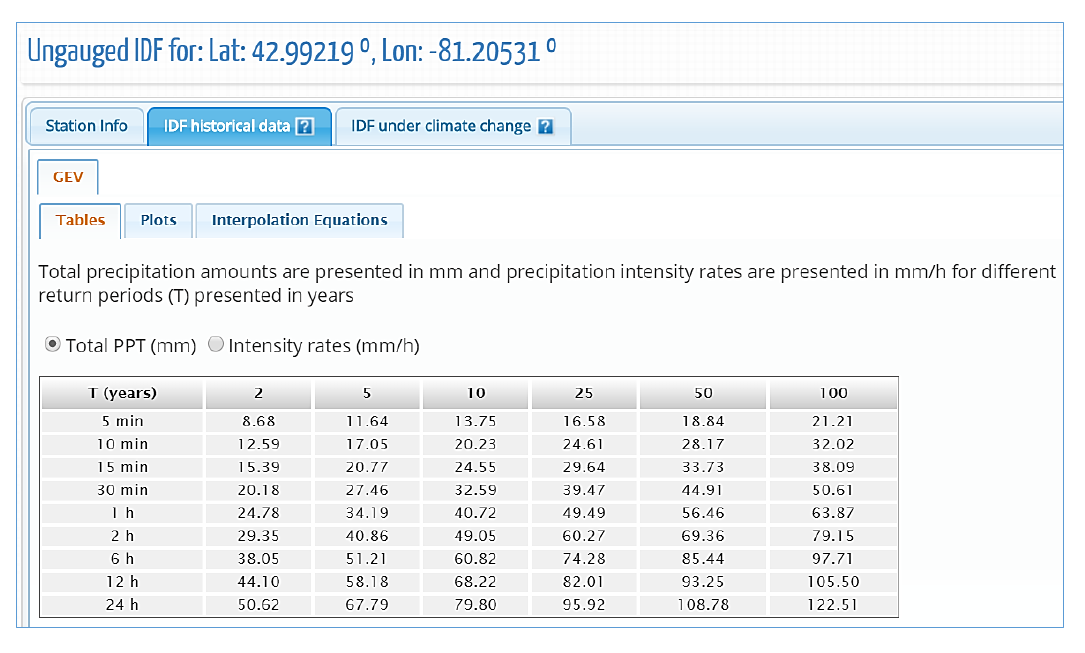
Figure 12. IDF table for an ungagged location for a given pair of coordinates.